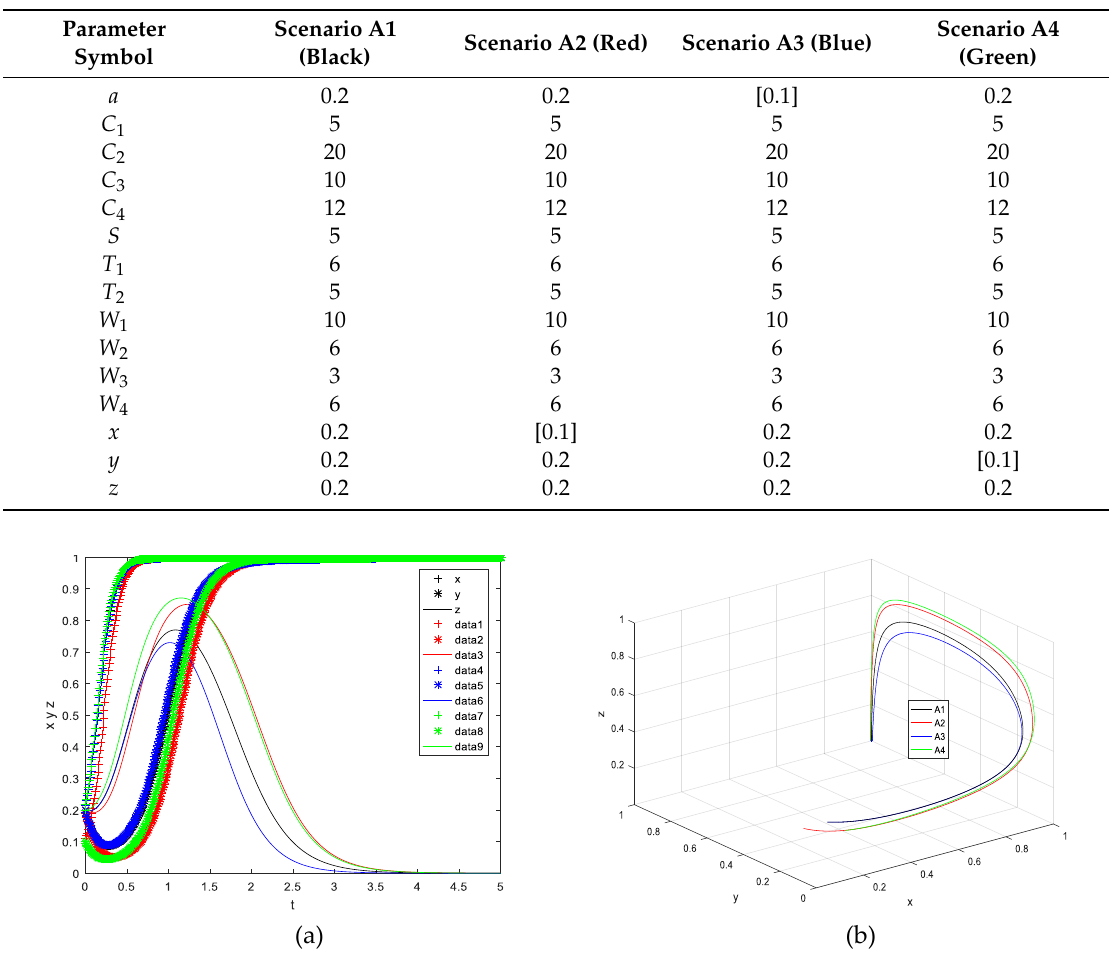
Figure 4. System evolution trend chart of oversupply scenario. ( a ) Two-dimensional evolution diagram, ( b ) Three-dimensional evolution